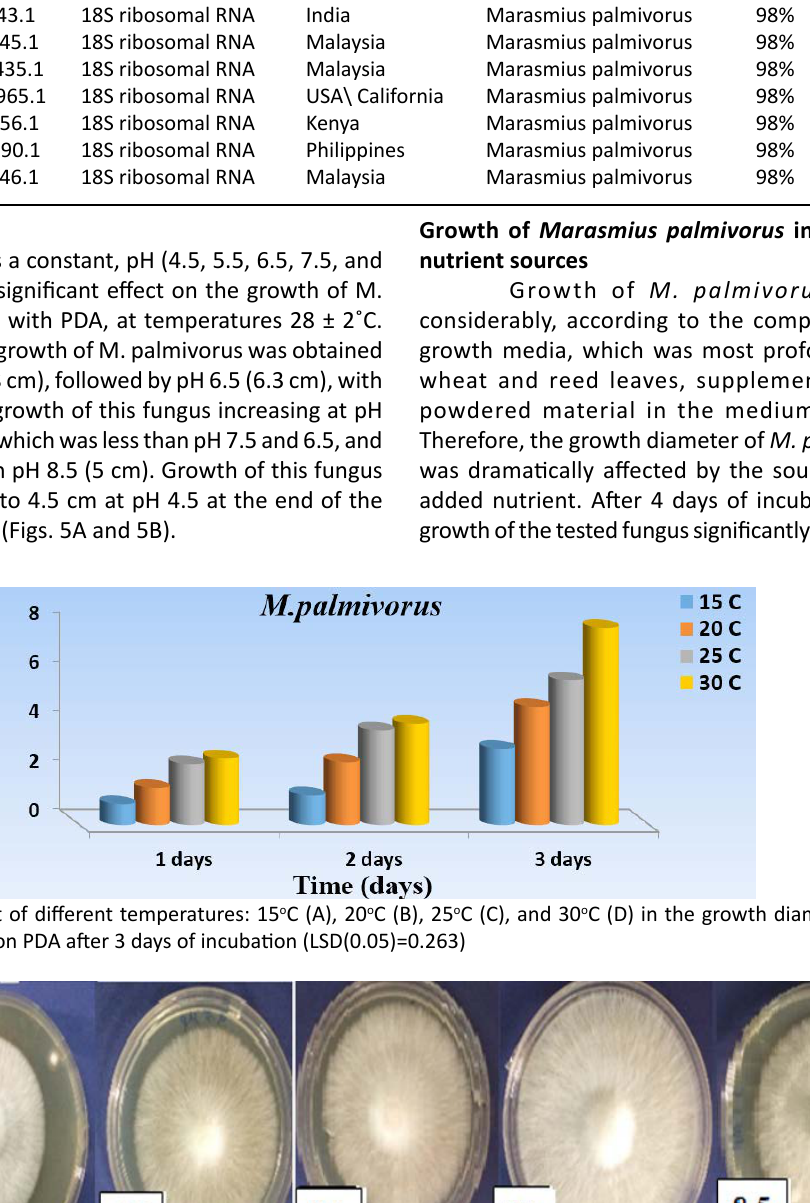
Table 1. Homology sequence identified for local Marasmius palmivorus isolate Accession Gene country Source